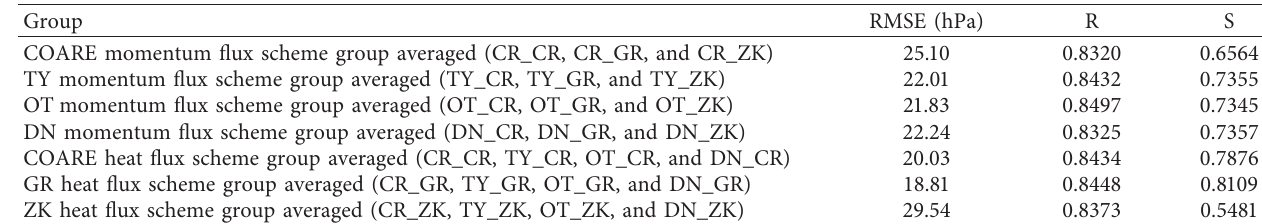
Table 4: Averaged root mean square error (RMSE), Pearson correlation coefficient (R), and model skill (S) for MSLP from different schemes.